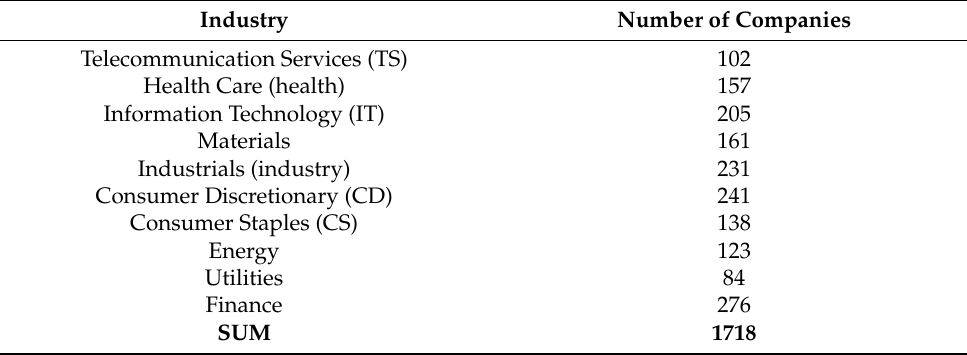
Table 2. Number of companies in the study by